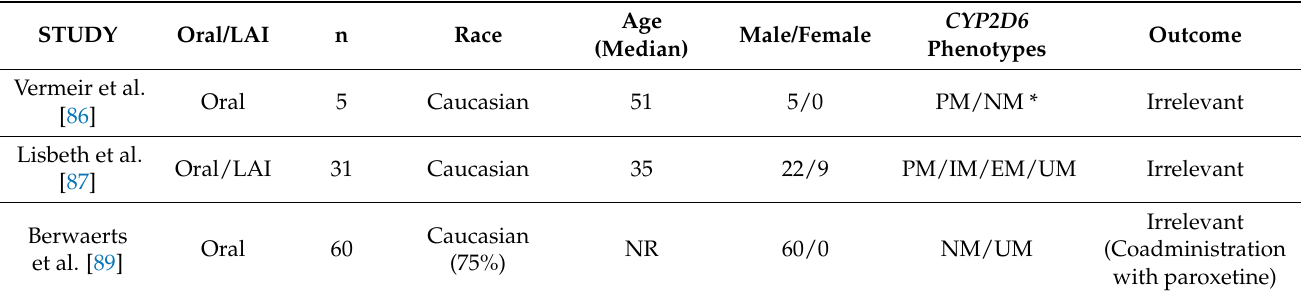
Table 5. Studies between CYP2D6 phenotype and the relation with paliperidone plasma